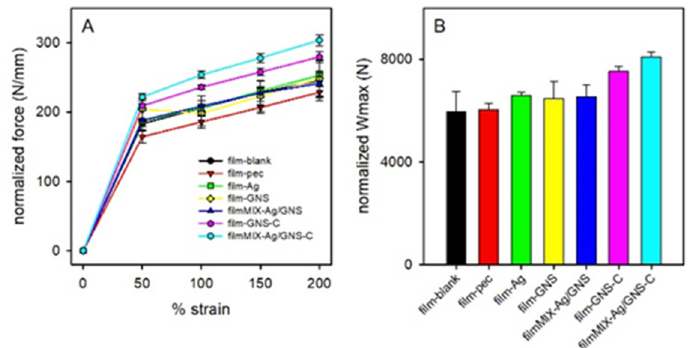
Figure 4. ( A ) Normalized force vs. strain profiles and ( B ) normalized work of deformation. Profiles and bars of the same colour in ( A , B ) refer to the same film.